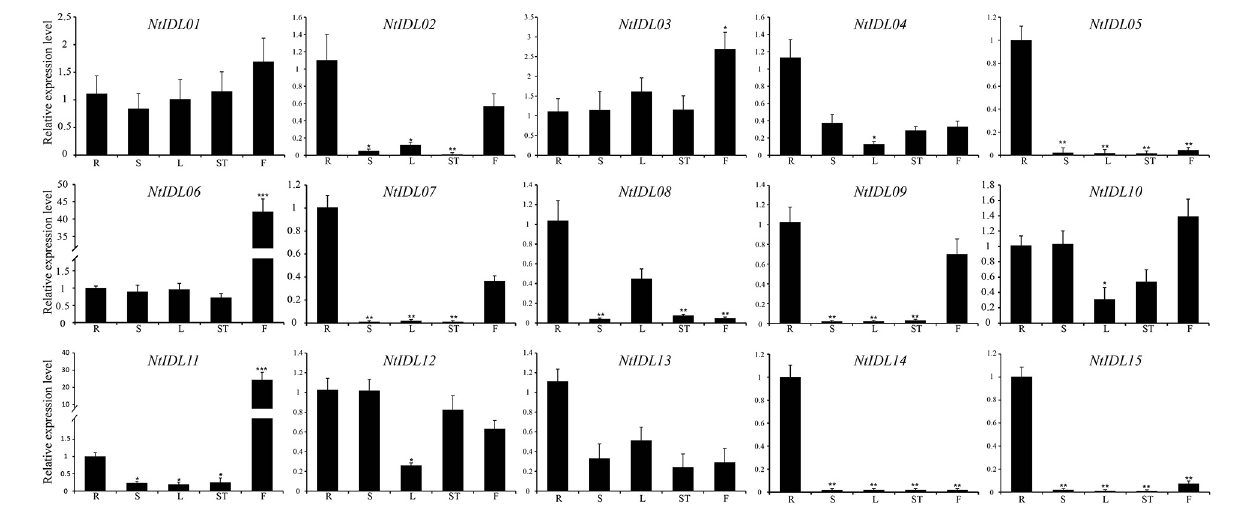
FIGURE 3 | The expression patterns of NtIDL genes in selected tissues. “R,” “S,” “L,” “ST,” and “F” mean roots, stems, leaves, shoots and flowers, respectively. Their expression was calculated as folds relative to the expression level of the roots to confirm the tissue specificity. All expression levels were calculated through the 2 − (cid:49)(cid:49) Ct method. The data were means ± SD from three independent replications. * p < 0.05, ** p < 0.01, and *** p < 0.001 ( t